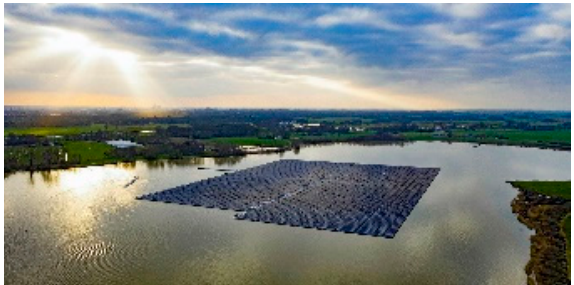
Figure 13. Saving the Mekong with Floating Solar Power. Photo: BayWa re rechargenews.com (accessed on 13 January 2021), Public Domain.